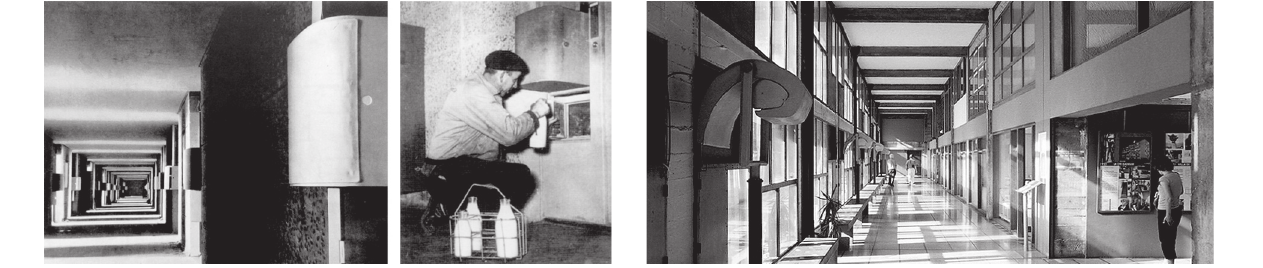
fig. 4. ‘unité d’Habitation’. a ‘rue intérieure’ (le Corbusier 1953: 205) and the daily delivery (Monteys 1996: 28)